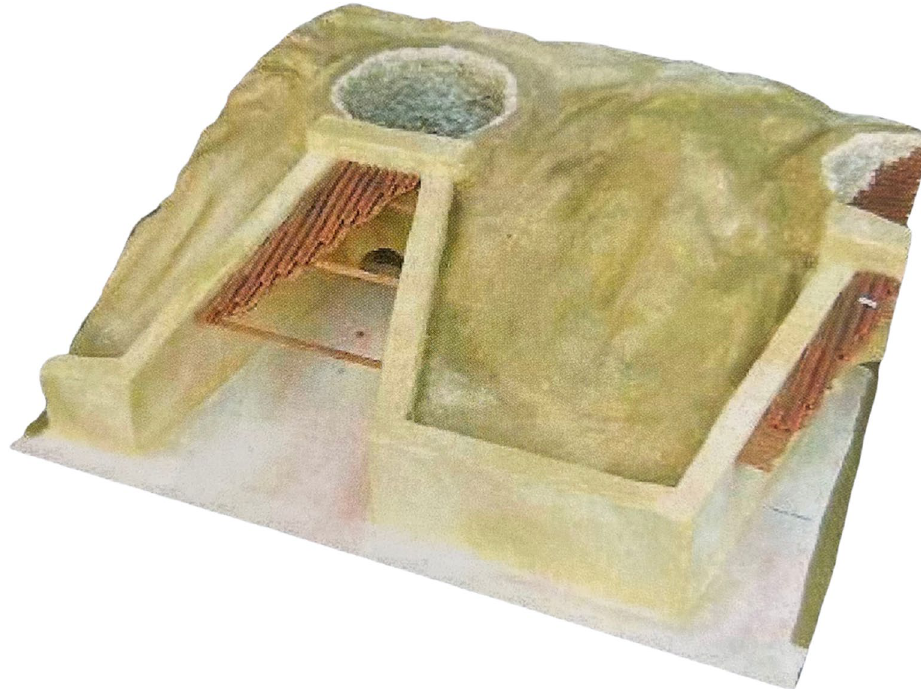
Fig. 10 Model of the twin furnaces of Caño del Loro. Source: (Cabrera Cruz et al.